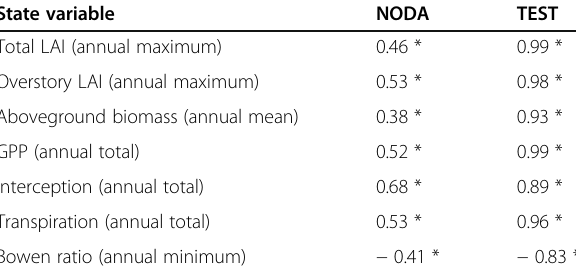
Table 3 Correlation coefficients for the spatial relationships between the variables and observed leaf area indices (LAI; annual maximum) for NODA and TEST. Asterisk * shows P values less than